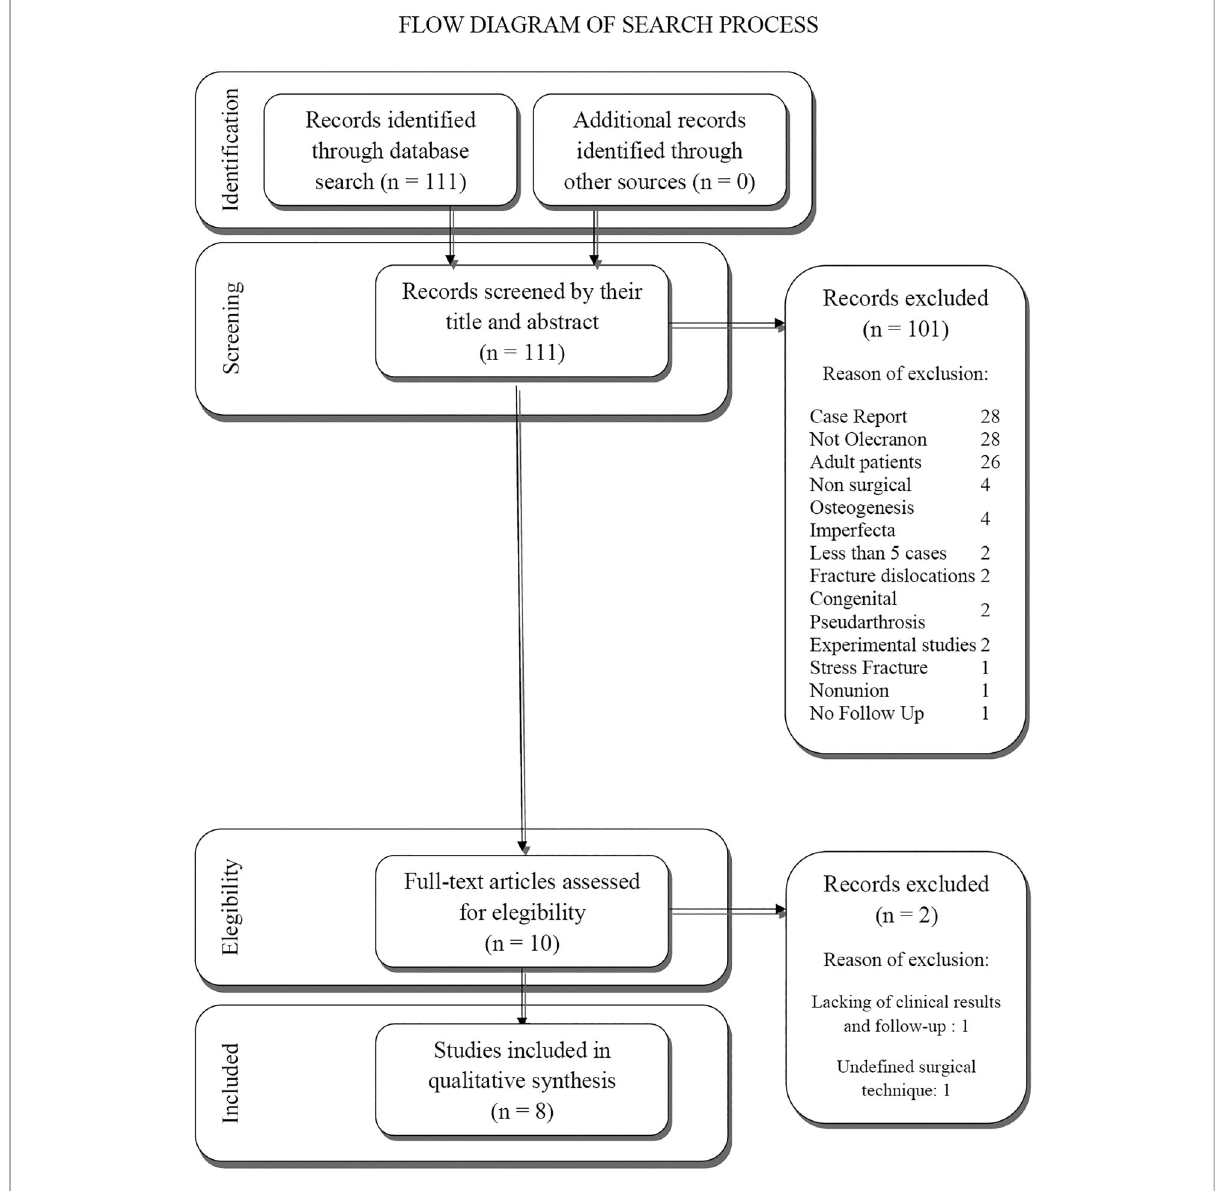
FIGURE 1 Flow diagram of search